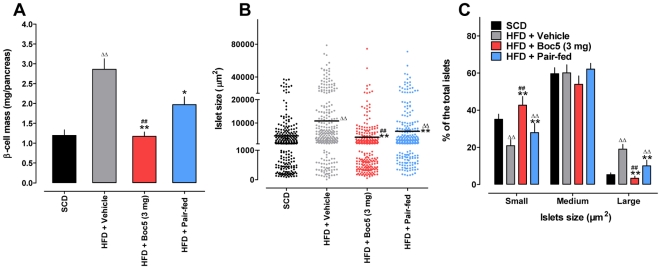
Effects of Boc5 on β-cell mass and islet size.(A) β-cell mass (6 sections per pancreas) was quantified using the Image-Pro Plus 6.0 software and calculated by multiplying the percentage of insulin-immunostained area by pancreatic weight. (B) The area of each islet was assessed by manually drawing around the islet perimeter with the measuring tool contained in the software. The total numbers of islets counted for each group were: 262, 299, 280 and 263, respectively. Y-Axis represents the islet size that was divided into three fractions: small, medium and large. (C) Distribution of small, medium and large islets as a percentage of the total islets in obese mice with or without 3 mg Boc5 treatment. Values represent mean±SEM. ΔΔ
P<0.01 compared with SCD group; *
P<0.05 and **
P<0.01 compared with HFD group; ##
P<0.01 compared with pair-fed group that received an equal amount of food as 3 mg Boc5-treated mice.